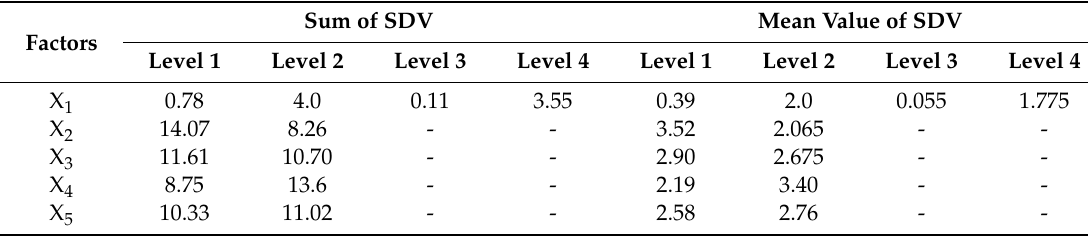
Table 3. Visual analysis results.